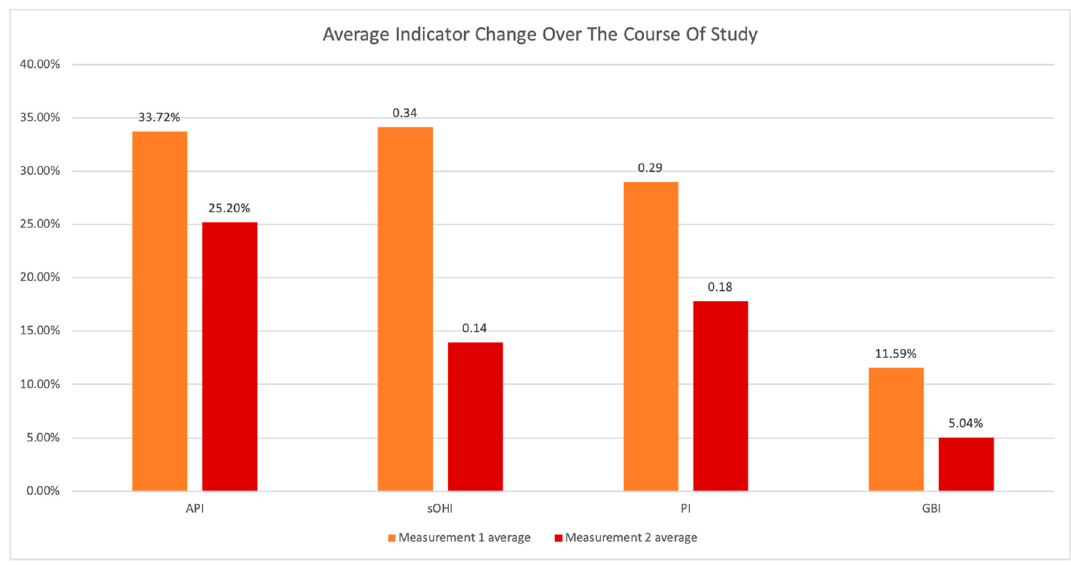
Figure 12. Average indicator change over the course of study.